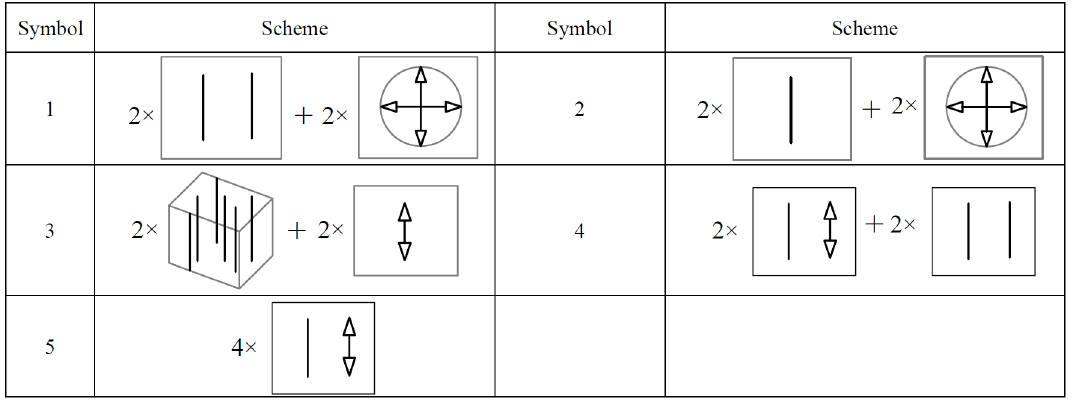
Table 6. Combination schemes.